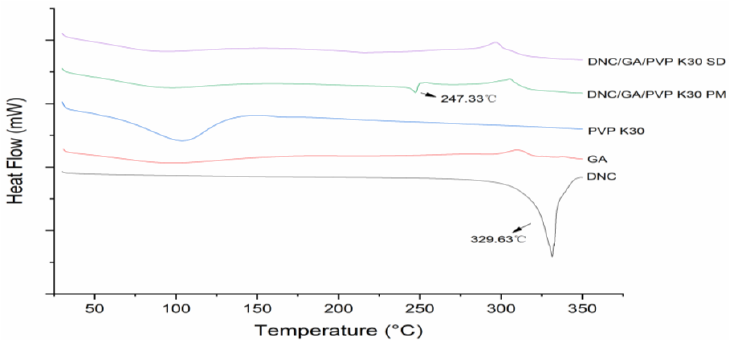
Figure 2. DSC curves of DNC, GA, PVP K30, DNC/GA/PVP K30 PM, and DNC/GA/PVP K30 SD.